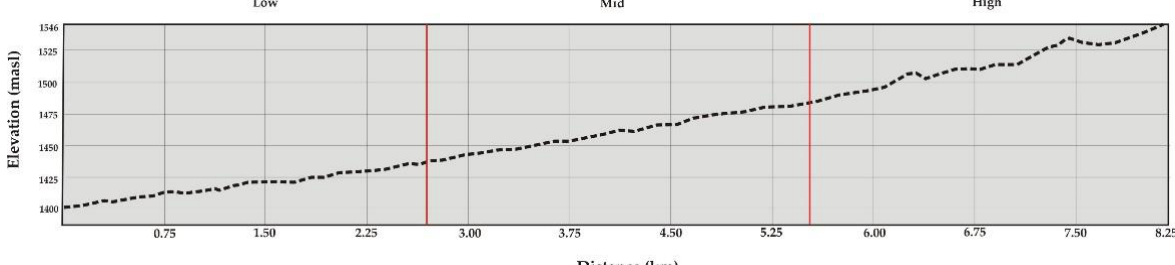
Figure 2. Profile of the study site illustrating the gradient from high (east) to low (west) elevation in meters above sea level (masl).